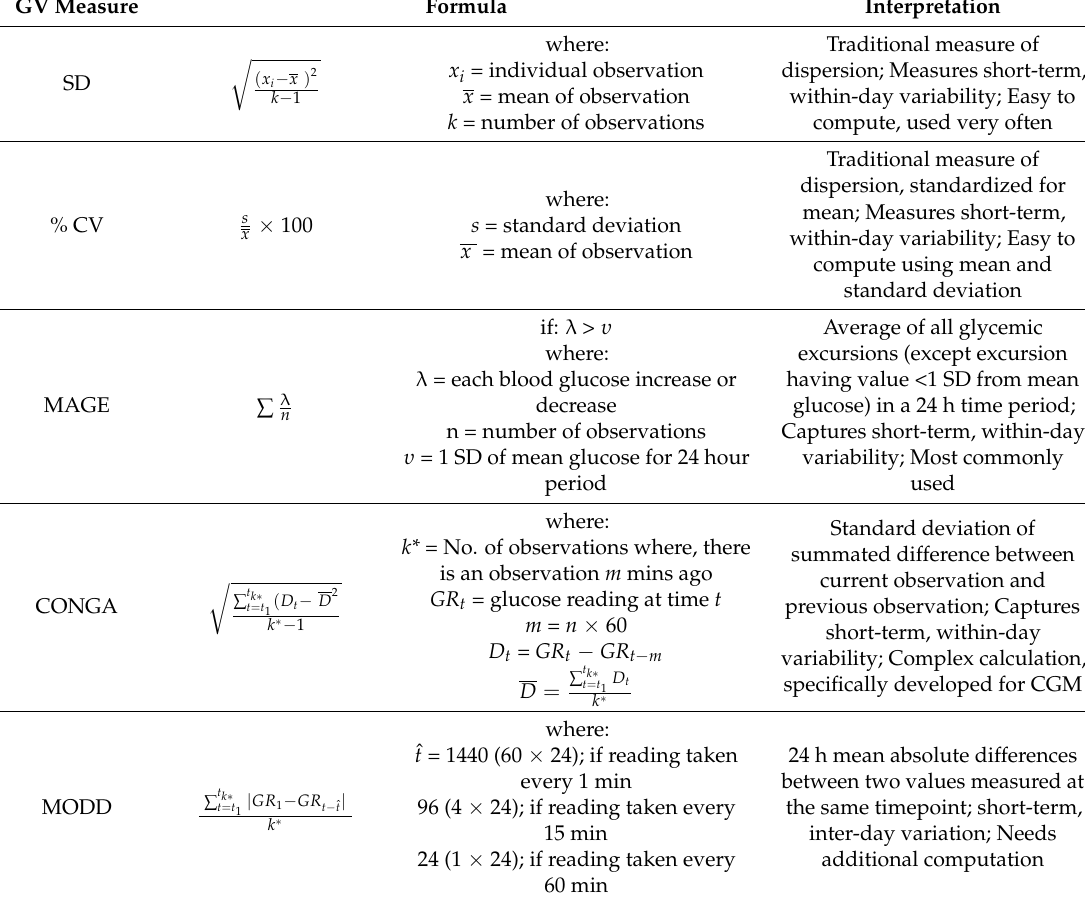
Table 1. Definitions of glycemic variability measures